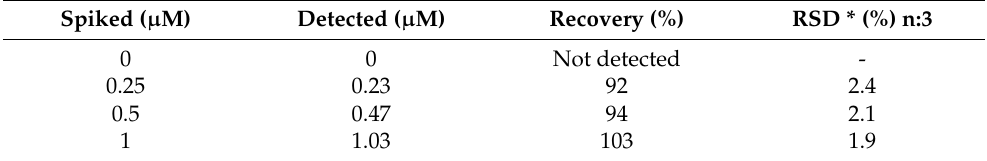
Table 2. Determination of Clz in spiked serum samples (1 µ M Clz in 10 mM PBS pH 7.4). Spiked ( µ